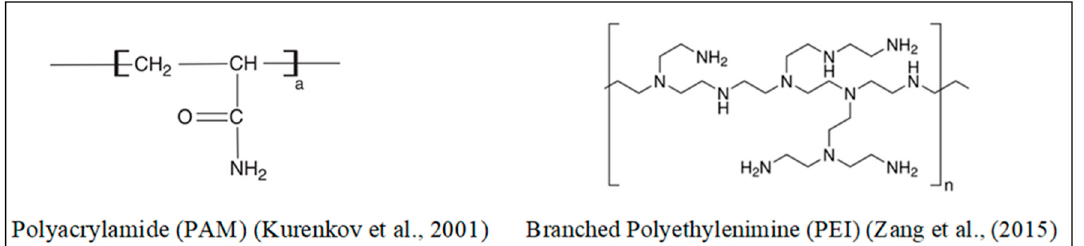
Figure 1. Chemical structure of polyacrylamide (PAM) and branched polyethyleneimine (PEI).